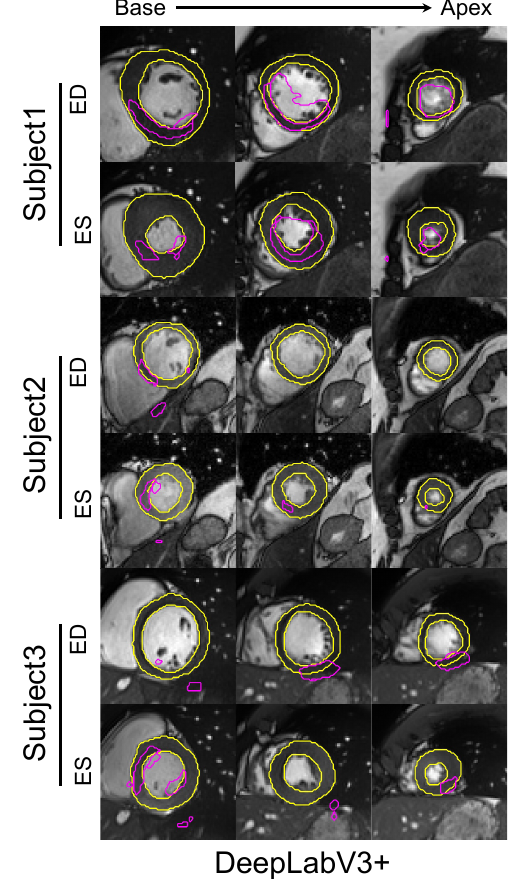
Figure A1. Representative segmentation of different regions of the heart at end-systole and end- diastole for the same three subjects as that in Figure 2 using DeepLabV3+. Algorithm and manual segmentation are shown in purple and yellow, respectively. ED: end-diastole; ES: